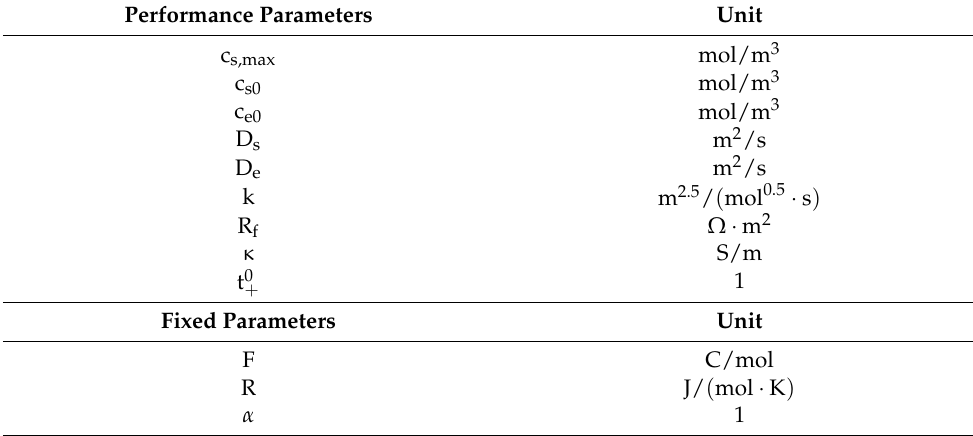
Table 2. Cont. Performance